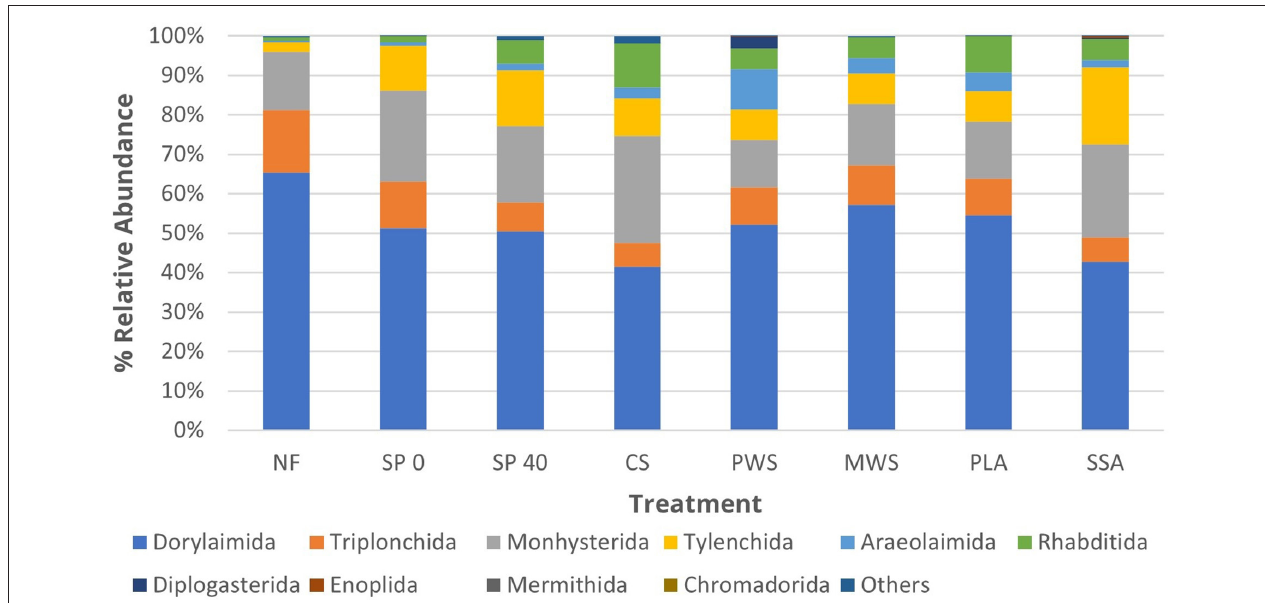
FIGURE 3 | The average relative abundance of the top 10 nematode orders in each treatment group ( n = 5). Treatment group name: NF, No fertilizer; SP0, No phosphate; SP40, mineral super phosphate; CS, cattle slurry; PWS, potato waste struvite; MWS, municipal waste struvite; PLA, poultry litter ash; SSA, sewage sludge ash.